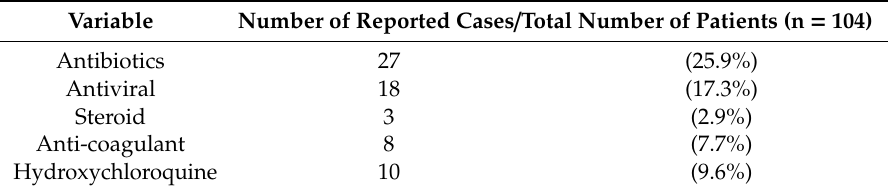
Table 5. Treatment of pregnant patients with